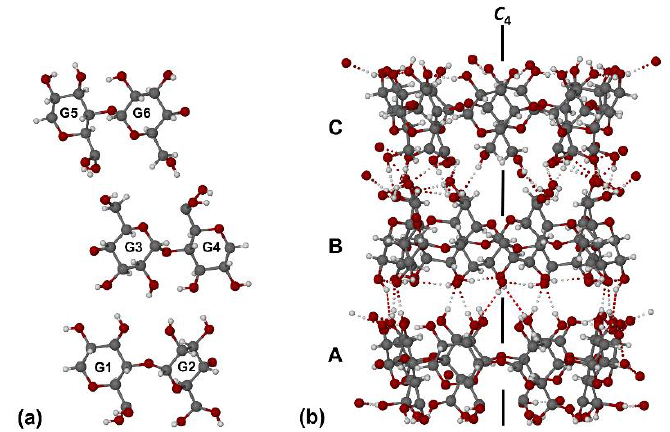
Figure 13. Thethreedistinctpairsofglucopyranoseunitsintheasymmetricunitofthe( γ -CD) 3 · (RSV) 4 · (H 2 O) 62 Figure 13. The three distinct pairs of glucopyranose units in the asymmetric unit of the (γ- complex ( a ) and the resulting stacking of the three unique γ -CD molecules parallel to the crystal c-axis ( b ). CD) 3 ·(RSV) 4 ·(H 2 O) 62 complex ( a ) and the resulting stacking of the three unique γ-CD molecules Intramolecular and intermolecular O-H ··· O hydrogen bonds are indicated by dotted parallel to the crystal c-axis ( b ). Intramolecular and intermolecular O-H···O hydrogen bonds are indicated by dotted lines.